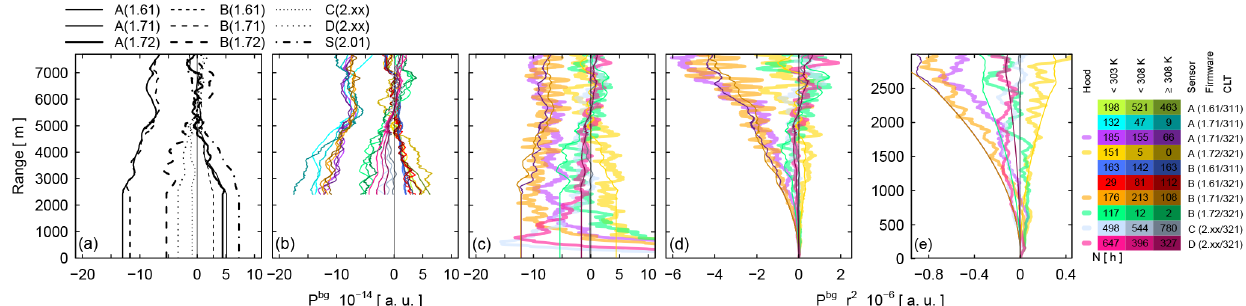
Figure 3. Long-term median vertical profiles of range-dependent, instrument-related background P bgi for Vaisala CL31 sensors (Table 2). Statistics are based on hourly mean profiles ( r >2410m) of the signal P (derived from reported signal by reverting range correction) observed around midnight (same data as Fig. 2). Ceilometers A and B operated with firmware 1.61, 1.71, or 1.72 and transmitter type CLT311 or CLT321, respectively; ceilometers C and D operated with CLT321 and firmware 2.01, 2.02, and 2.03; ceilometer S operated with firmware 2.01 and CLT321. (a) Median profiles for each sensor calculated separately by firmware version for sensors A and B, all of which are combined for C and D (2.xx) due to their similarity. (b) As in (a) for sensors A, C, B, and D but also separating by ceilometer transmitter CLT and laser heat sink temperature combinations (see legend); laser heat sink temperature (reported by the ceilometer as laser temperature) is used to subdivide profiles into three classes ( T laser <303K, 303K ≤ T laser <308K, and T laser ≥ 308K). (c) As in (b) but for selected profiles (solid lines, A and B with 1.71 and 1.72; C and D with 2.03) and their respective background profiles as determined by a 30min termination hood measurement at the same setting and laser heat sink temperature class (thick lines). (d) As in (c) but range-corrected. (e) As in (d) but zoomed into the range <3000m. Number of hourly mean profiles N (h) available for each combination of sensor, firmware, transmitter type CLT, and laser heat sink temperature is listed in the legend. Profiles are smoothed vertically with a moving average over a window of 210m; only for profiles from sensor B is a smoothing window of 310m